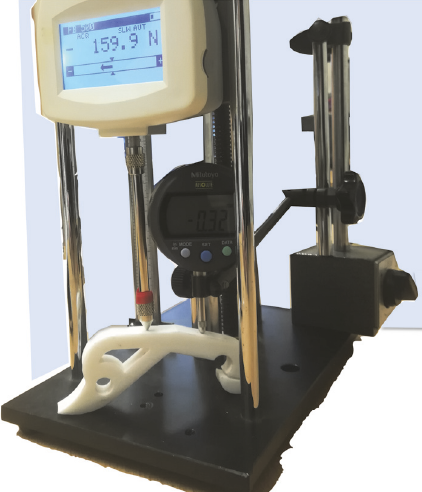
Figure 2: Experimental setup. A mechanical load of 159.9 N is applied on the top of the part in white. A displacement is measured at a fixed